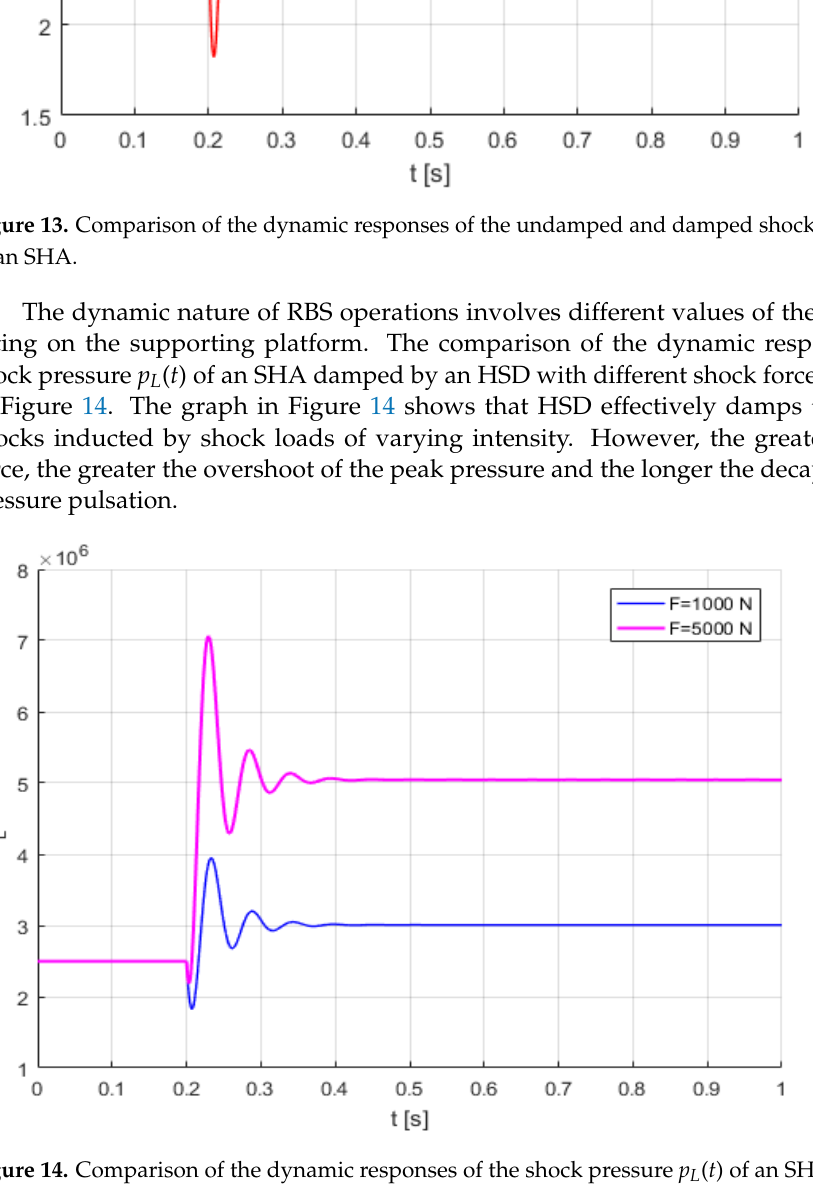
an HSD with different shock force F .